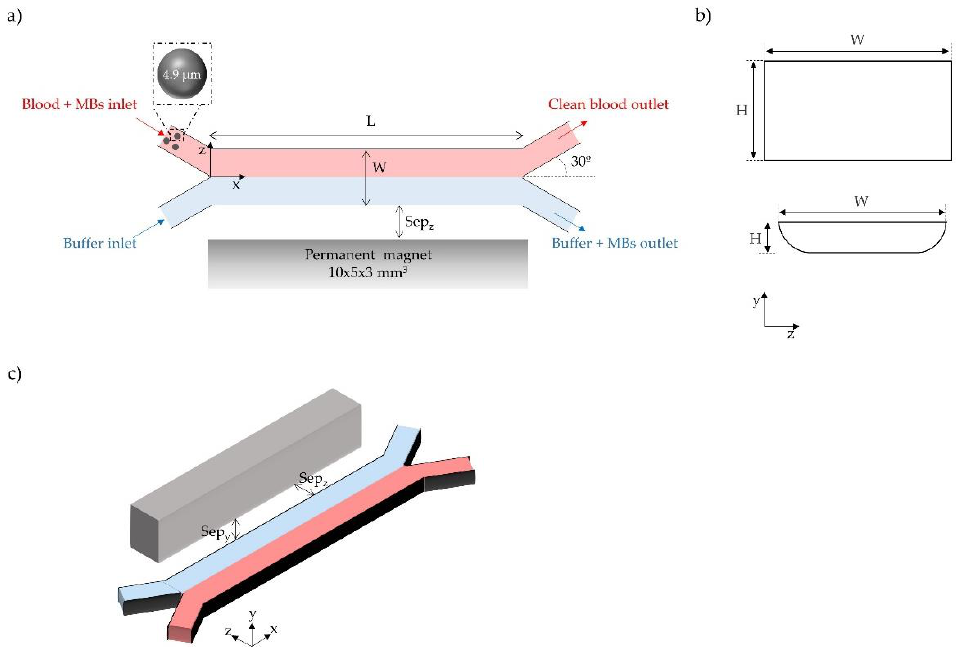
Figure 1. ( a ) Top view of the microfluidic-magnetophoretic device, ( b ) Schematic representation of the channel cross-sections studied in this work, and ( c ) the magnet position relative to the channel location (Sep y and Sep z are the magnet separation distances in y and z, respectively).